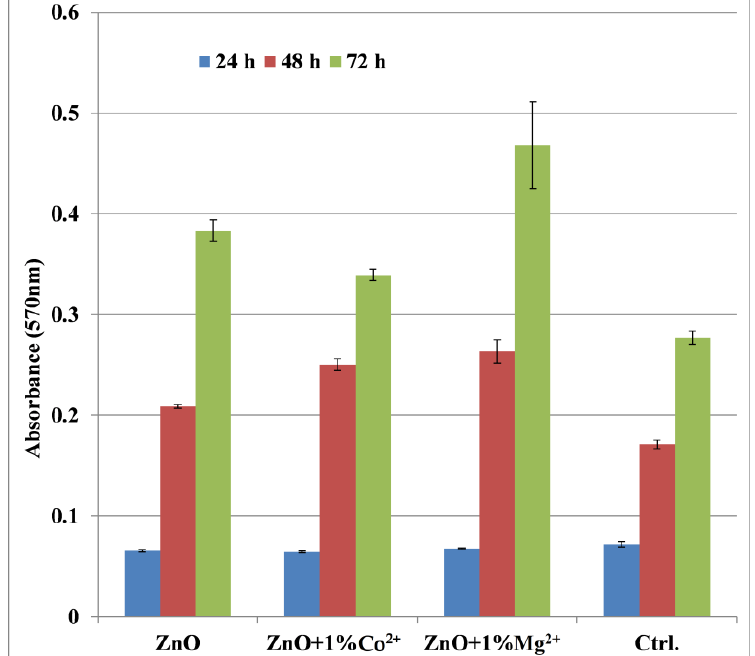
Figure 8. The MTT assay on undoped and Co 2+ /Mg 2+ -doped ZnO films coatings on TiAlV alloy substrate.